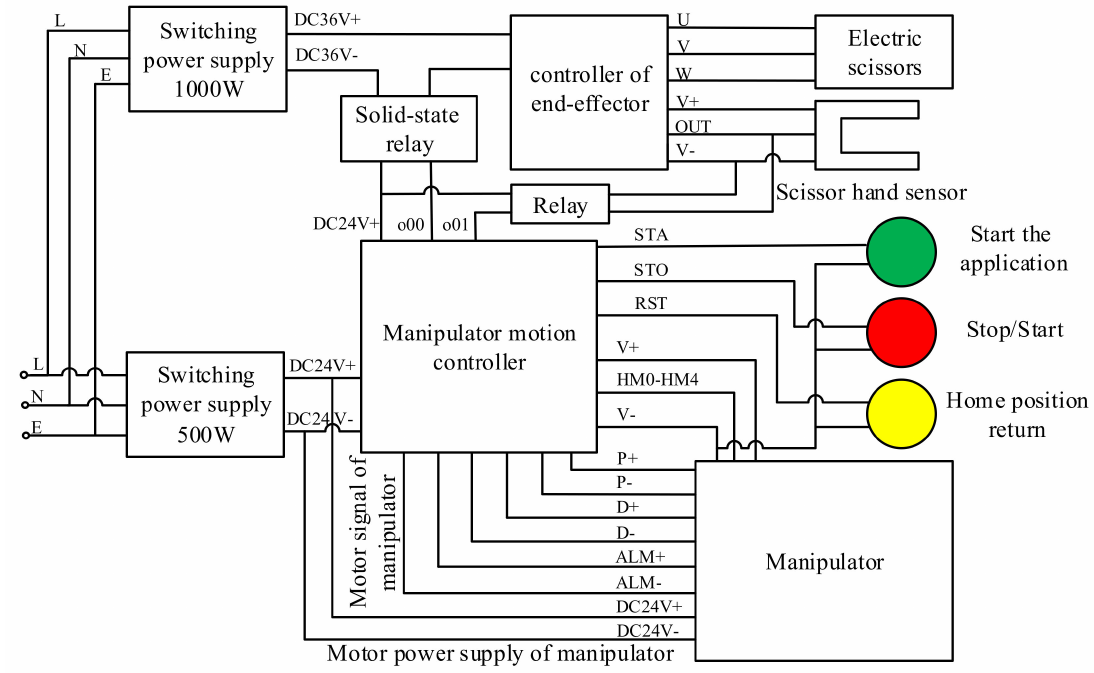
Figure 8. The diagram for the electrical schematic of the jujube pruning